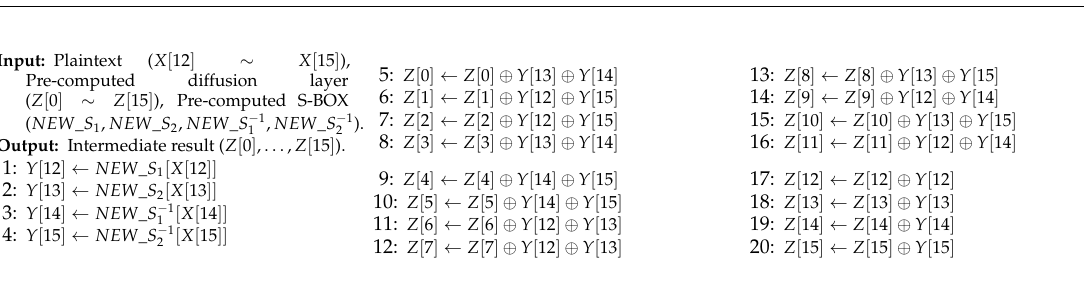
Algorithm 9 Online: LUT based computations for